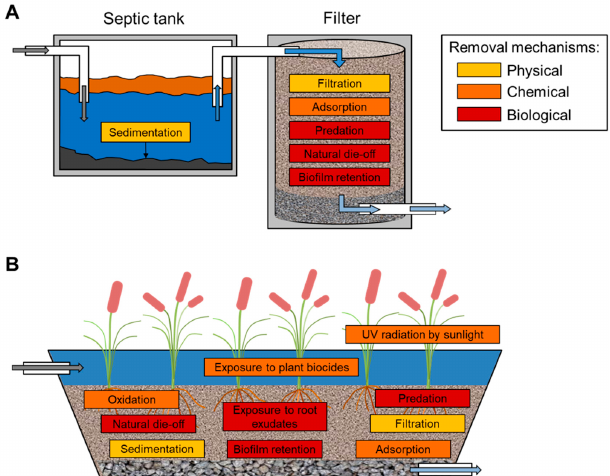
Figure 1. The removal mechanisms of pathogens in OWTSs. ( A ): Major pathogen removal mecha- nisms involved in a conventional septic tank and sand filtration system. ( B ): Major pathogen re- moval mechanisms involved in a constructed wetland.